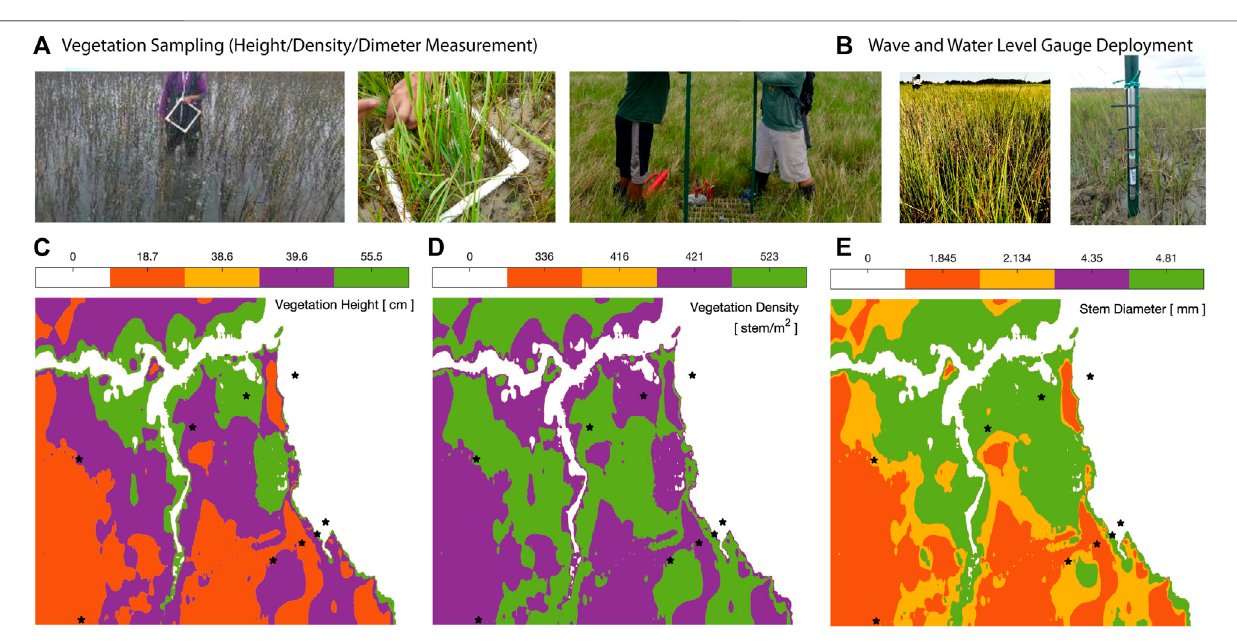
Frontiers in Built Environment |